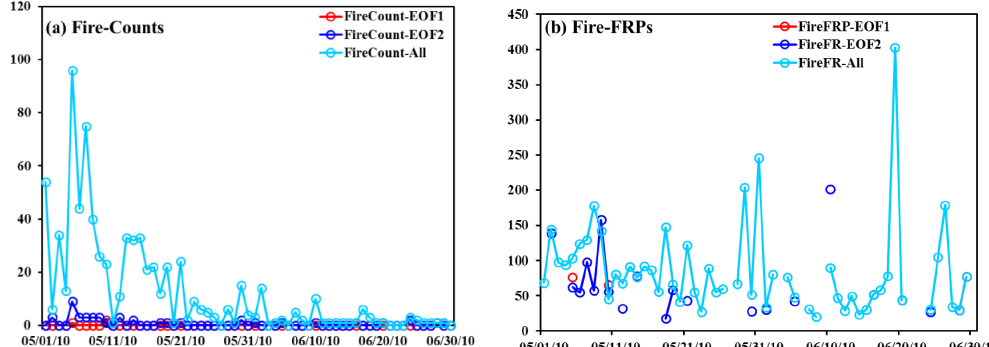
Figure 8. Spatially averaged/aggregated statistics of (a) MODIS fire numbers (count) and (b) fire radiative power (FRP) over Southeast Asia for May and June 2010. The statistics represent the respective count (total number of burning 1km × 1km pixels) and average FRP [Wm − 2 per 1km × 1km pixel] over the whole of Southeast Asia and the specific regions where the AOD (as an indicator for smoke) has its highest levels of variability: EOF1 and EOF2.